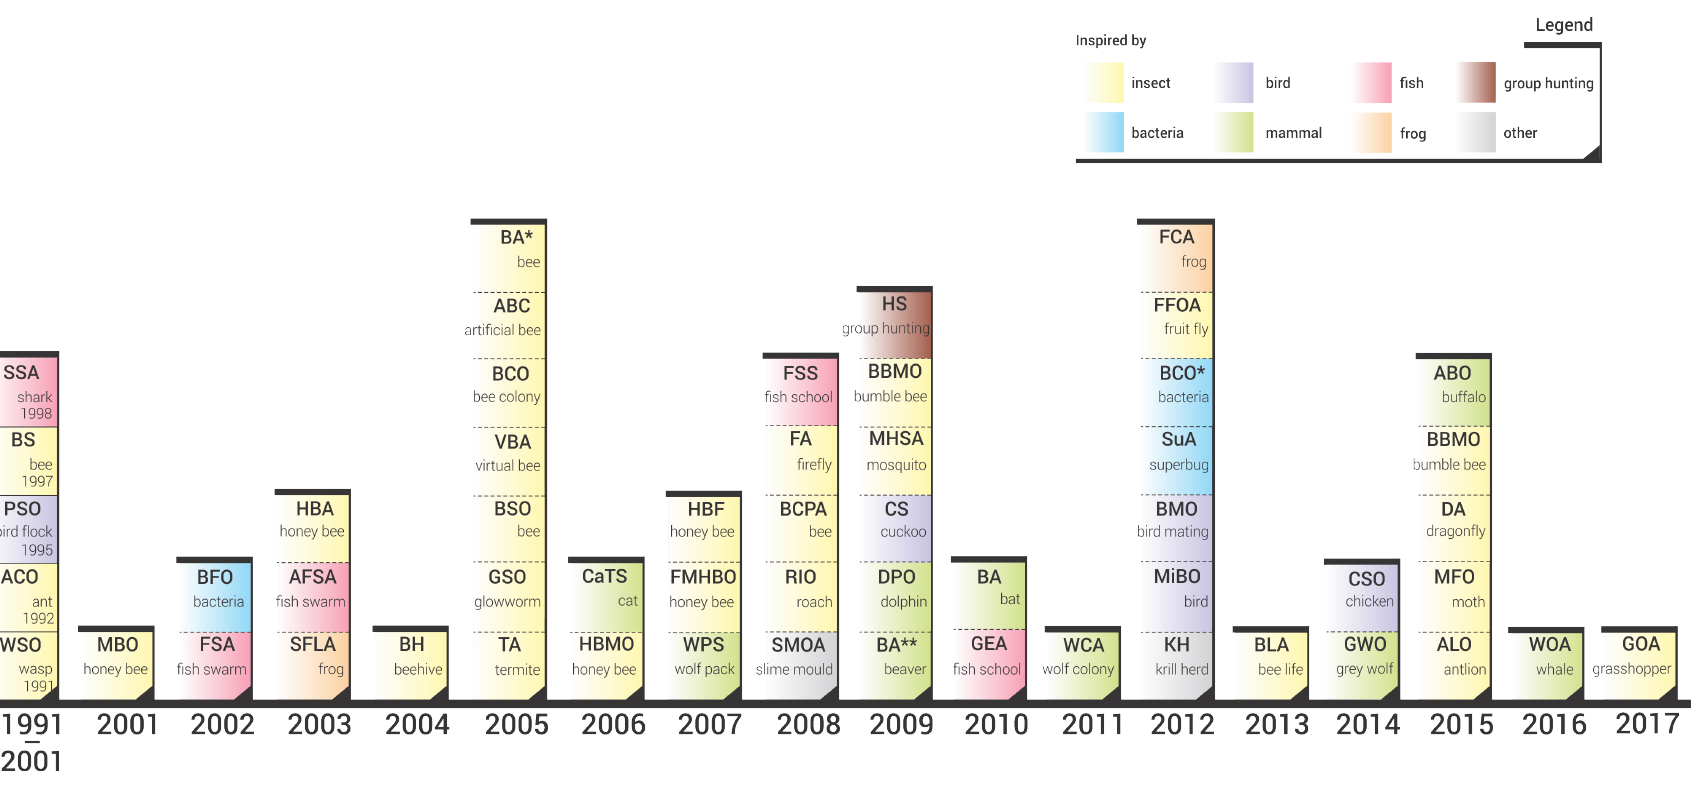
Figure 2. Swarm intelligence algorithms. * are added because the same abbreviations are used for different algorithms (see Table A1 in the Appendix